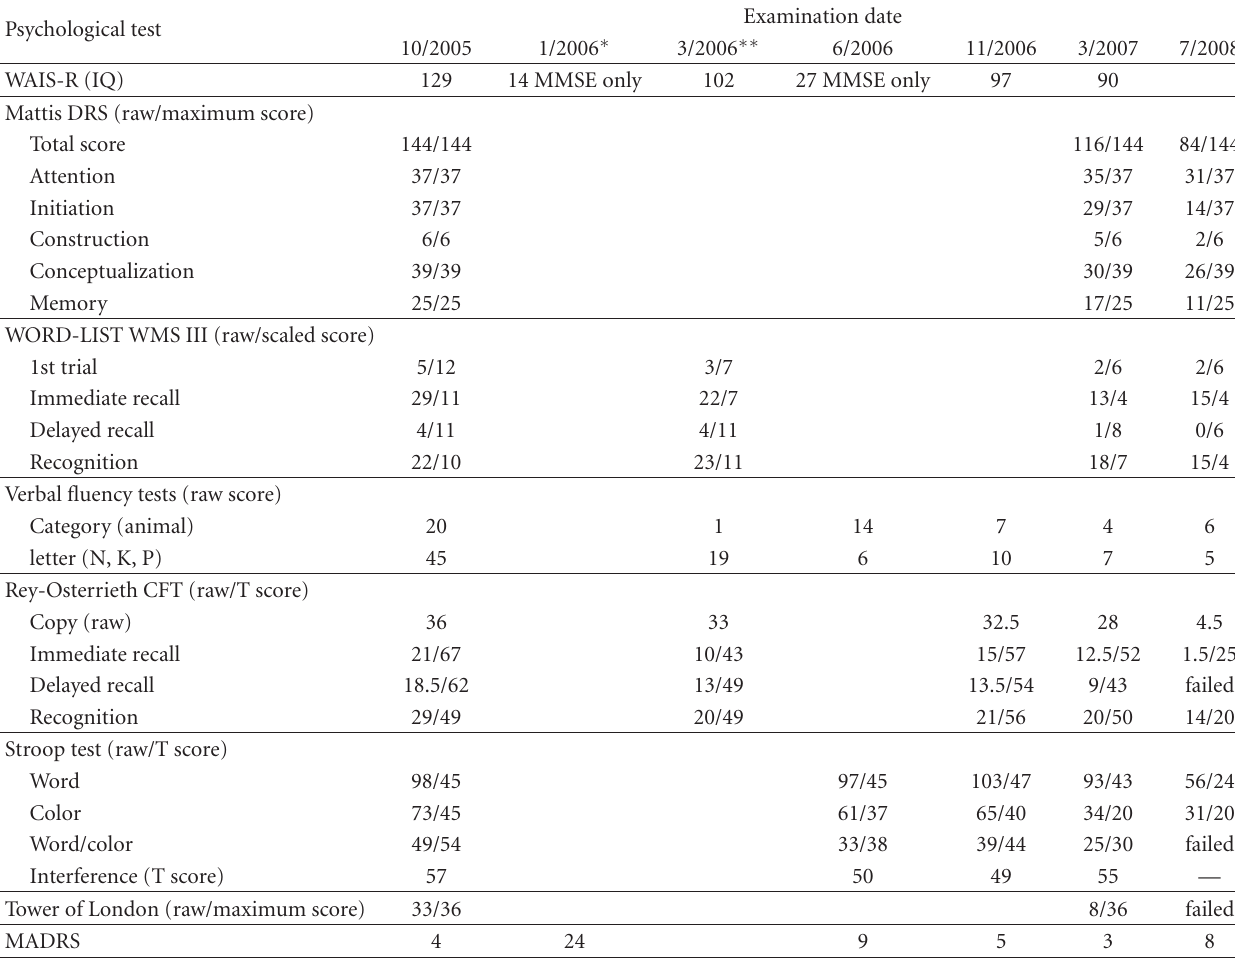
Table 1: Neuropsychological test battery results.